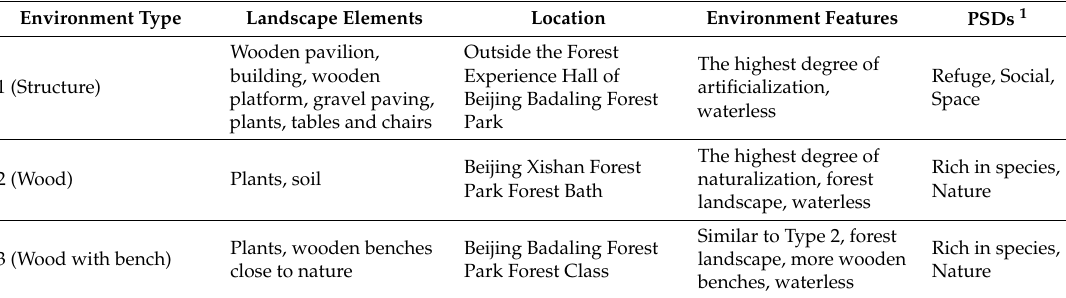
Table 1. Seven di ff erent types of forest resting